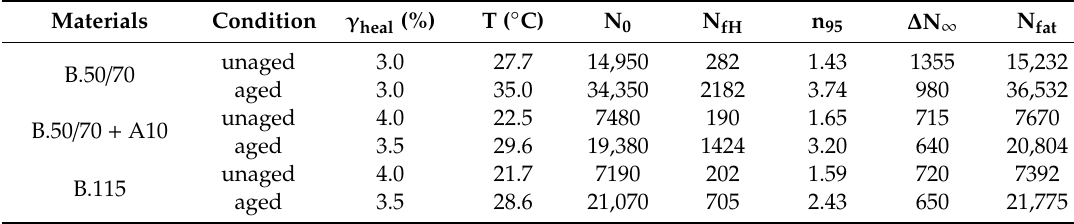
Table 5. Healing parameters in iso-stiffness conditions ( |G ∗ | ∙ sin δ = 3 MPa).